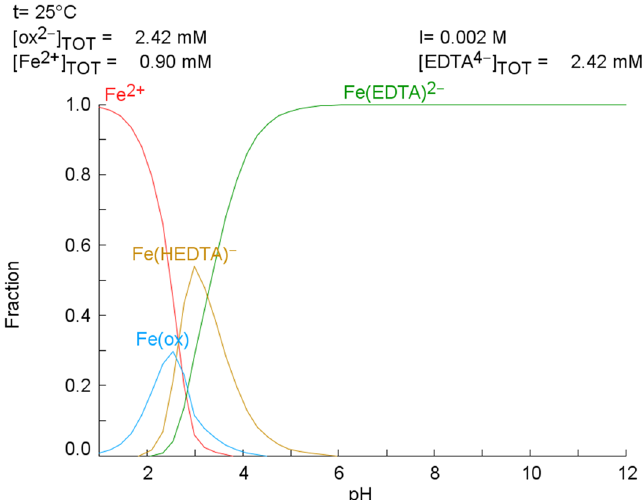
Fig. 4 Distribution diagram of iron species as a function of pH. Drawn using Spana software, Royal Institute of Technology,